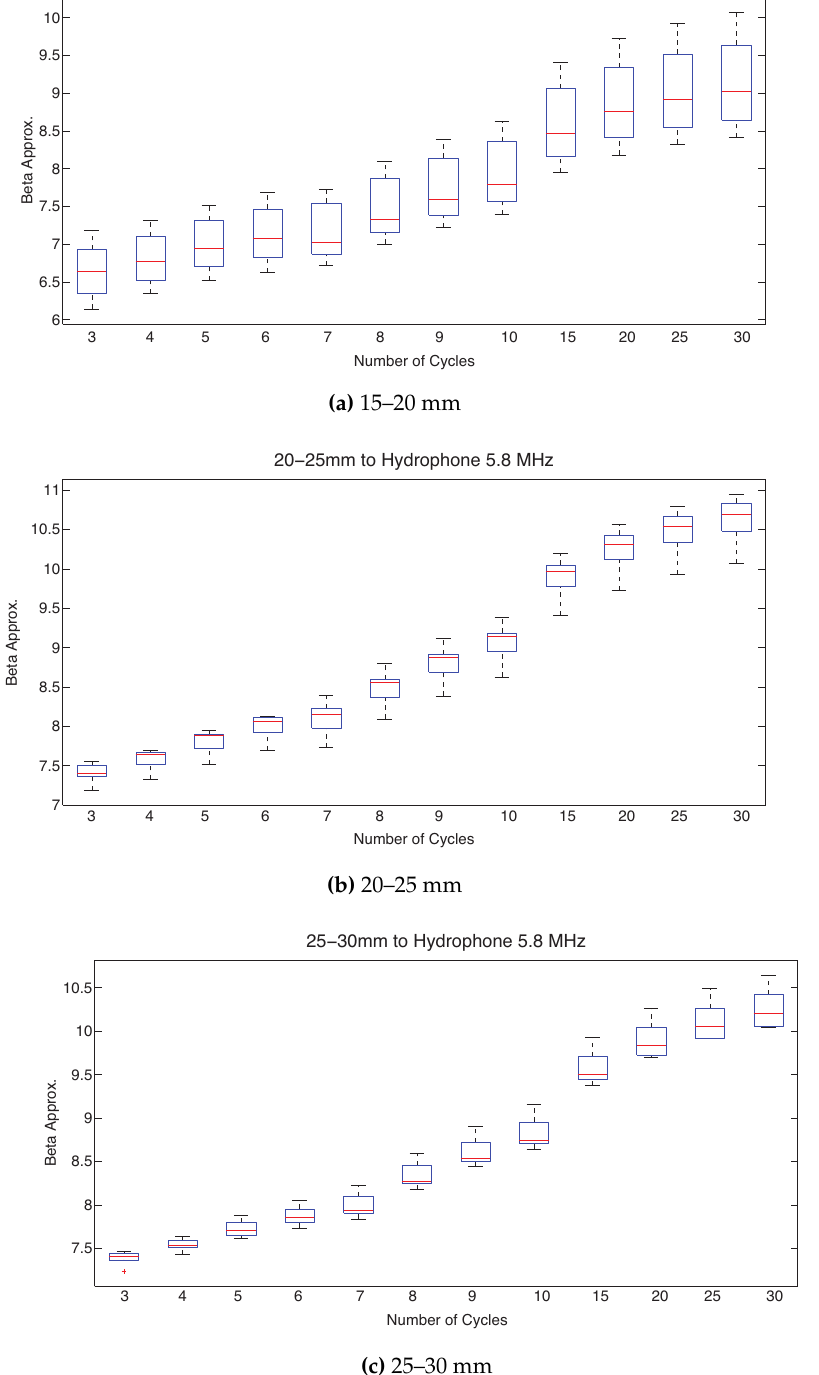
Figure 14. Box-plot beta versus cycles using a frequency of 5.8 MHz. Mean and standard deviation values are computed considering different distances specimen-hydrophone: in ( a ) distance 15–20 mm, in ( b ) distance 20–25 mm and in ( c ) distance 25–30